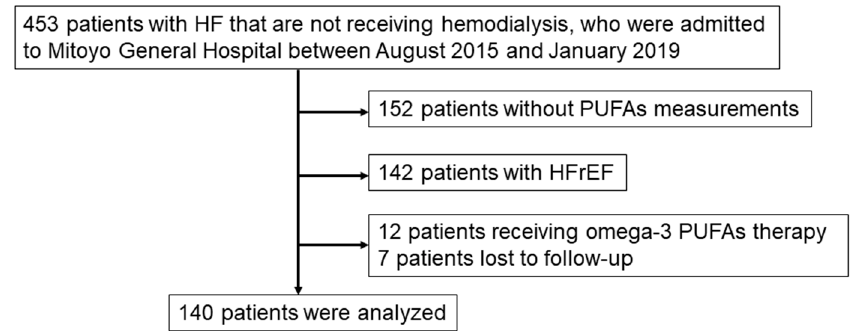
Figure 1. Flowchart of study population. Heart failure (HF) was defined based on the Framingham criteria. Heart failure with reduced ejection fraction (HFrEF); Heart failure with preserved ejection fraction (HFpEF) was defined as HF with a left ventricular ejection fraction ≥ 50%. PUFAs, polyunsatu- rated fatty